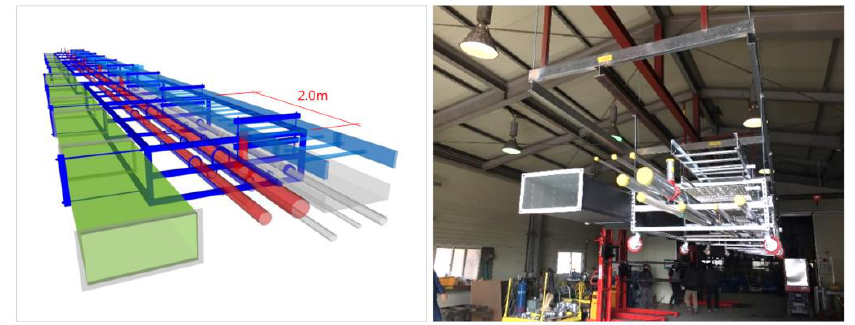
Figure 3. Type C: Frames with the ducts moved to the outside (supporting interval: 2 m).